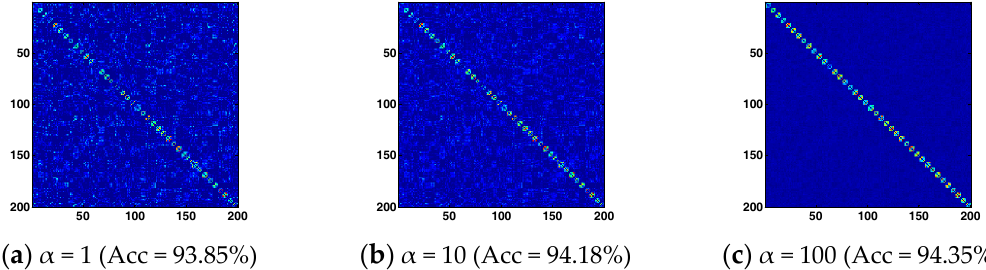
Figure 5 . Visualization of the graph weights and corresponding recognition accuracy obtained by BLSE. From left to right, α is 1, 10 and 100, respectively.